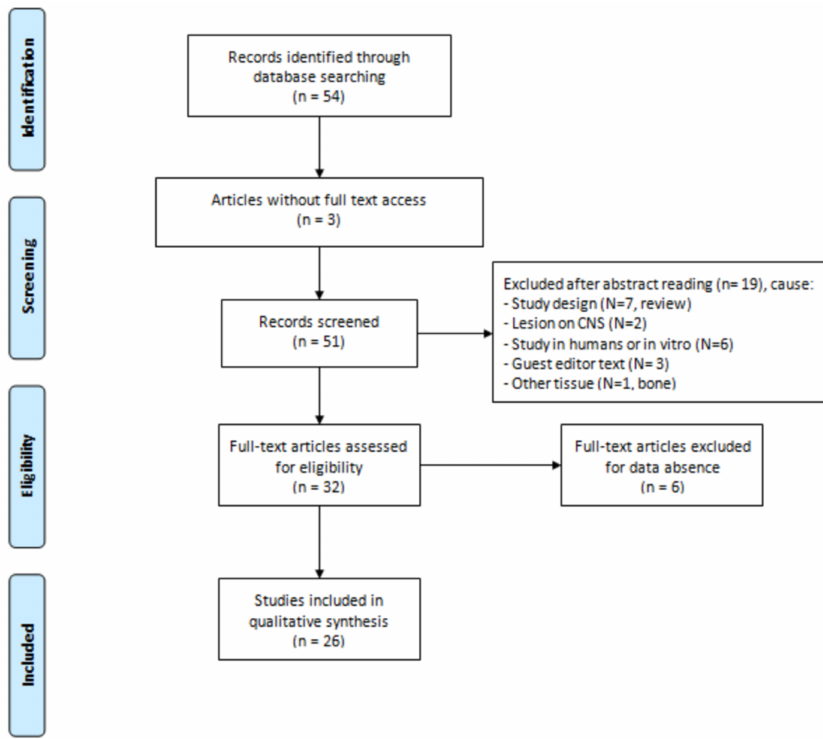
Figure 1. Design used to select the